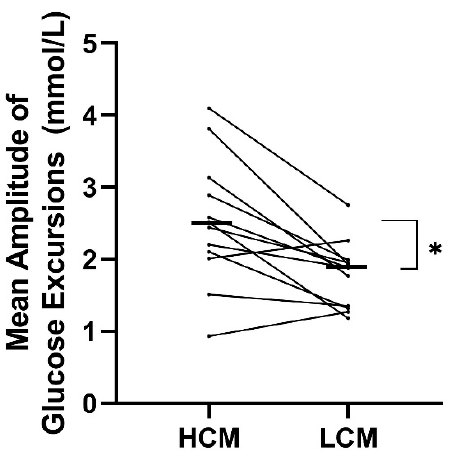
Figure 2. Treatment effect on mean amplitude of glucose excursions (MAGE) for each participant following a diet with two days of high carbohydrate load (HCM) and two days of low carbohydrate load (LCM) in the morning. Mean values of the treatment effect of each period are marked with black lines. HCM, high carbohydrate and energy content in the morning; LCM, low carbohydrate and energy content in the morning; MAGE, mean amplitude of glucose excursions.